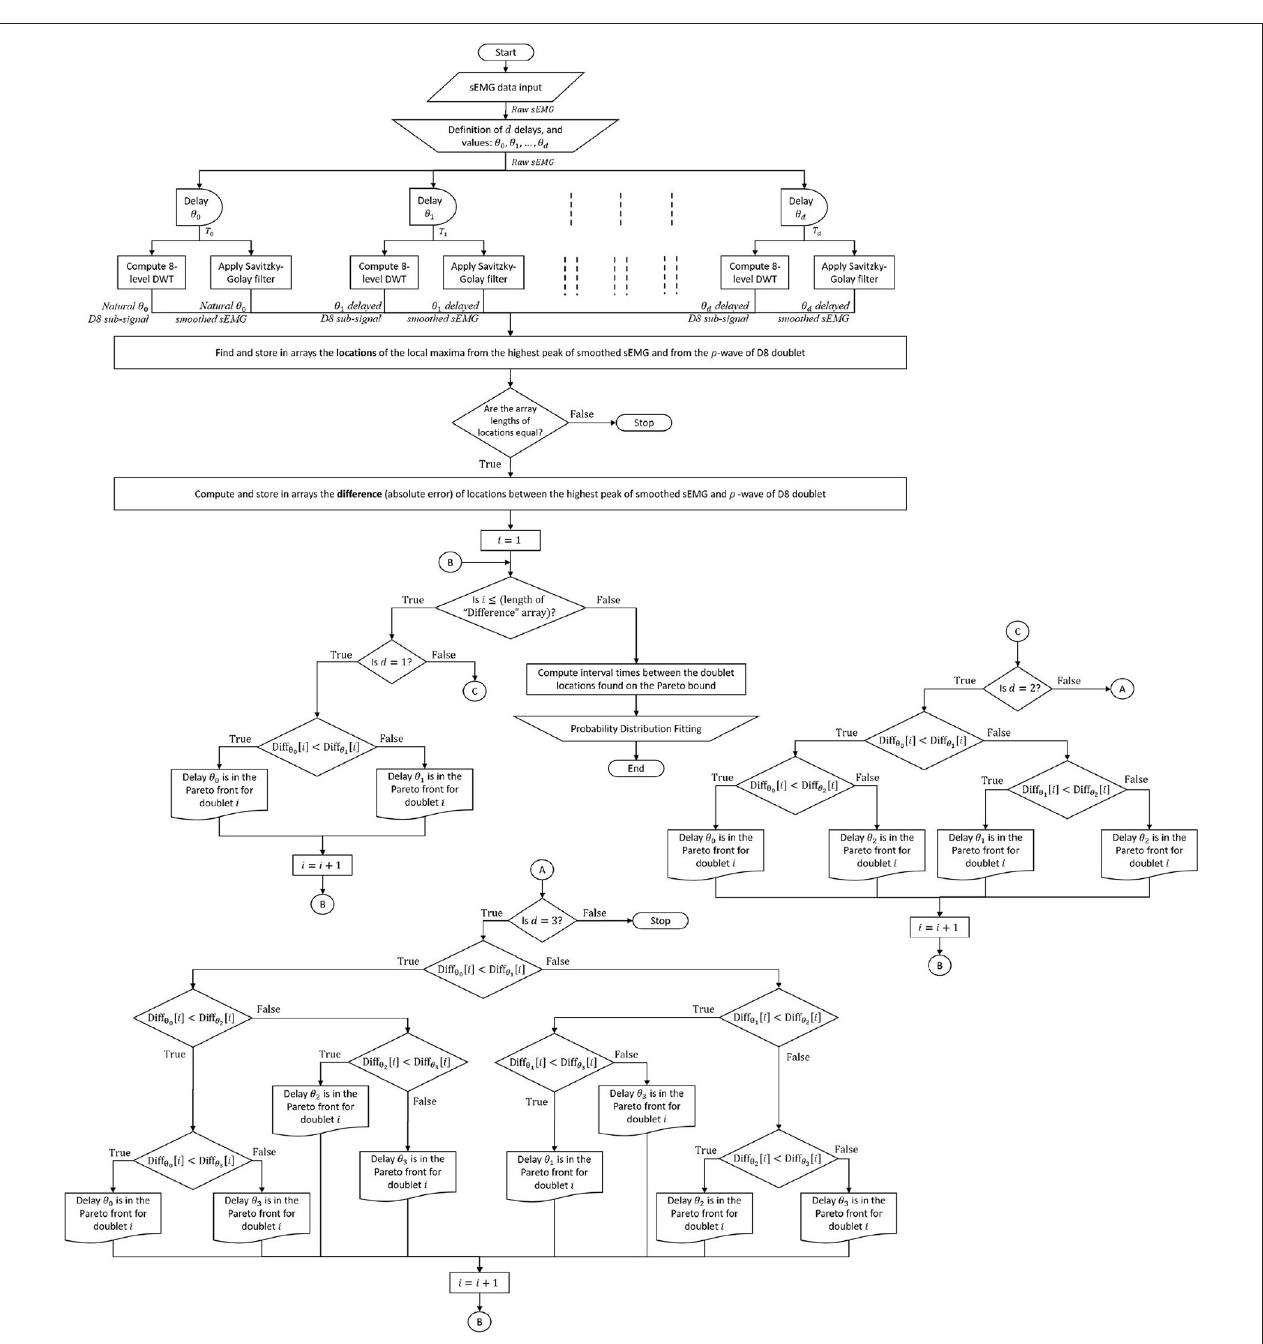
FIGURE 4 | Complete sEMG signal processing and analysis flowchart: The raw sEMG signal passes through d predefined delays to time shift its 8-level sub-signal and its smoothed sEMG signal. In the example of this paper, the number of delays is d = 3, with values of θ 0 = 0 ms, θ 1 = 5 ms, θ 2 = 10 ms, θ 3 = 15 ms, a guideline for defining the delay values is less than one cycle ( ≤ 30 ms) since Figure 3 spans half cycle (15 ms). The expert system finds the minimal error between local maximum of the sEMG burst and ρ -wave of its 8-level sub-signal (shown in Figure 3 ) among the ( d + 1) pairs of signals that come from the same sEMG trace, enhancing waveform matching and providing the Pareto front ρρ -interval times (and/or ρ -wave magnitudes) for probability distribution analysis.